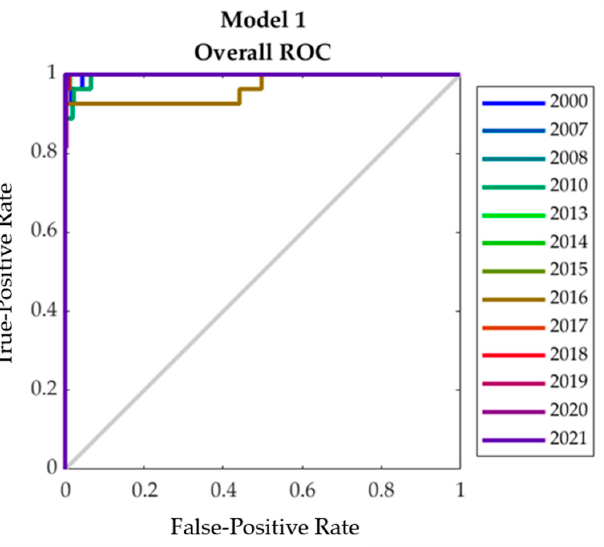
Figure 5. Overall receiver operating characteristics (ROC) curve showing the true-positive (sensitivity) and false-positive (specificity) rates of Model 1 for all vintages.